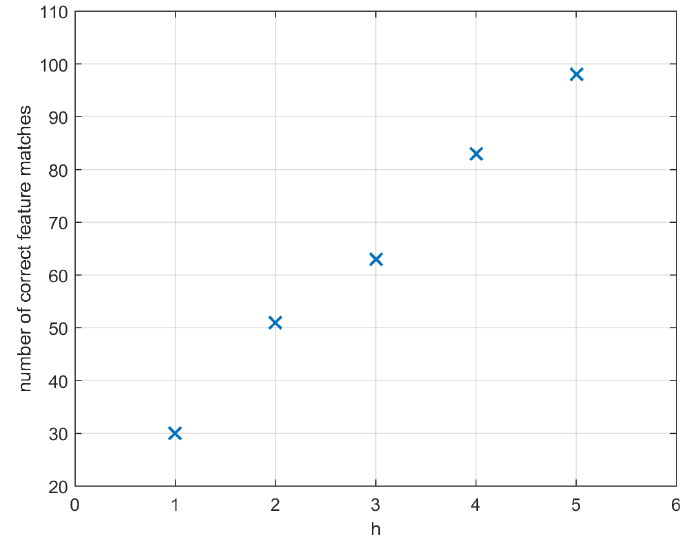
Figure 9. Number of correctly matched feature points by means of the technique proposed in Section 2 varying the number h of orientations to be compared: h = { 1, . . . ,5 }